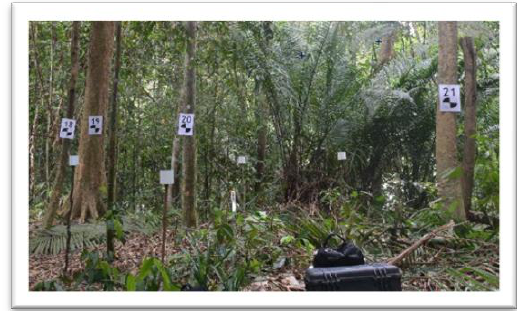
Figure 1. A sample plot photograph showing arrangement